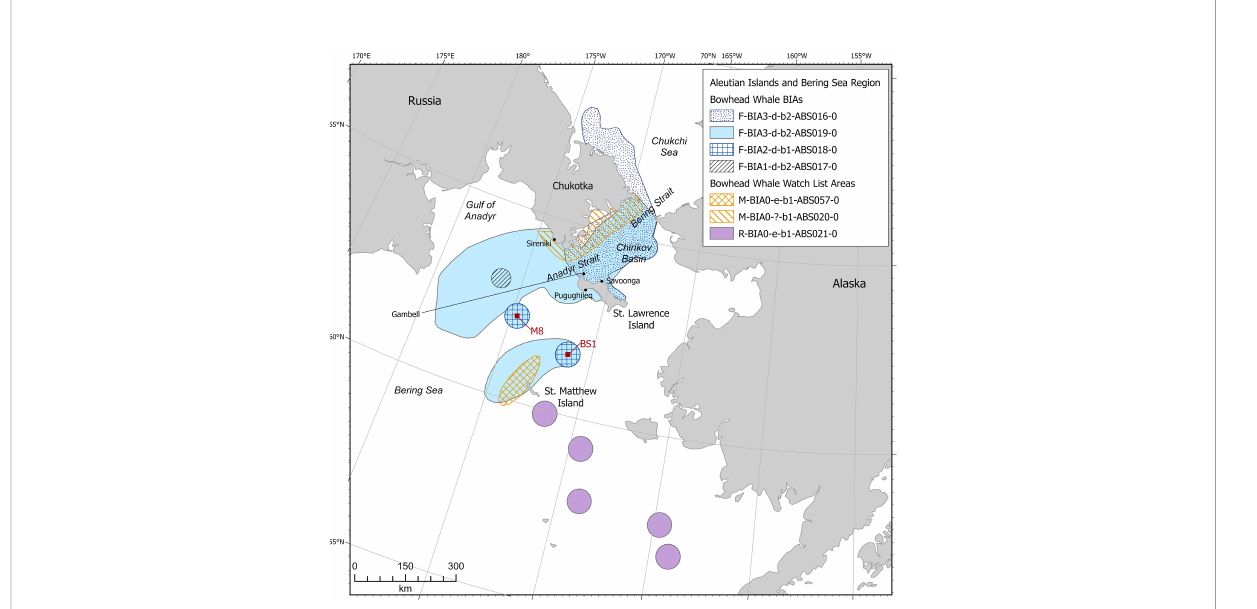
FIGURE 3 Aleutian Islands and Bering Sea region bowhead whale BIAs and watch list